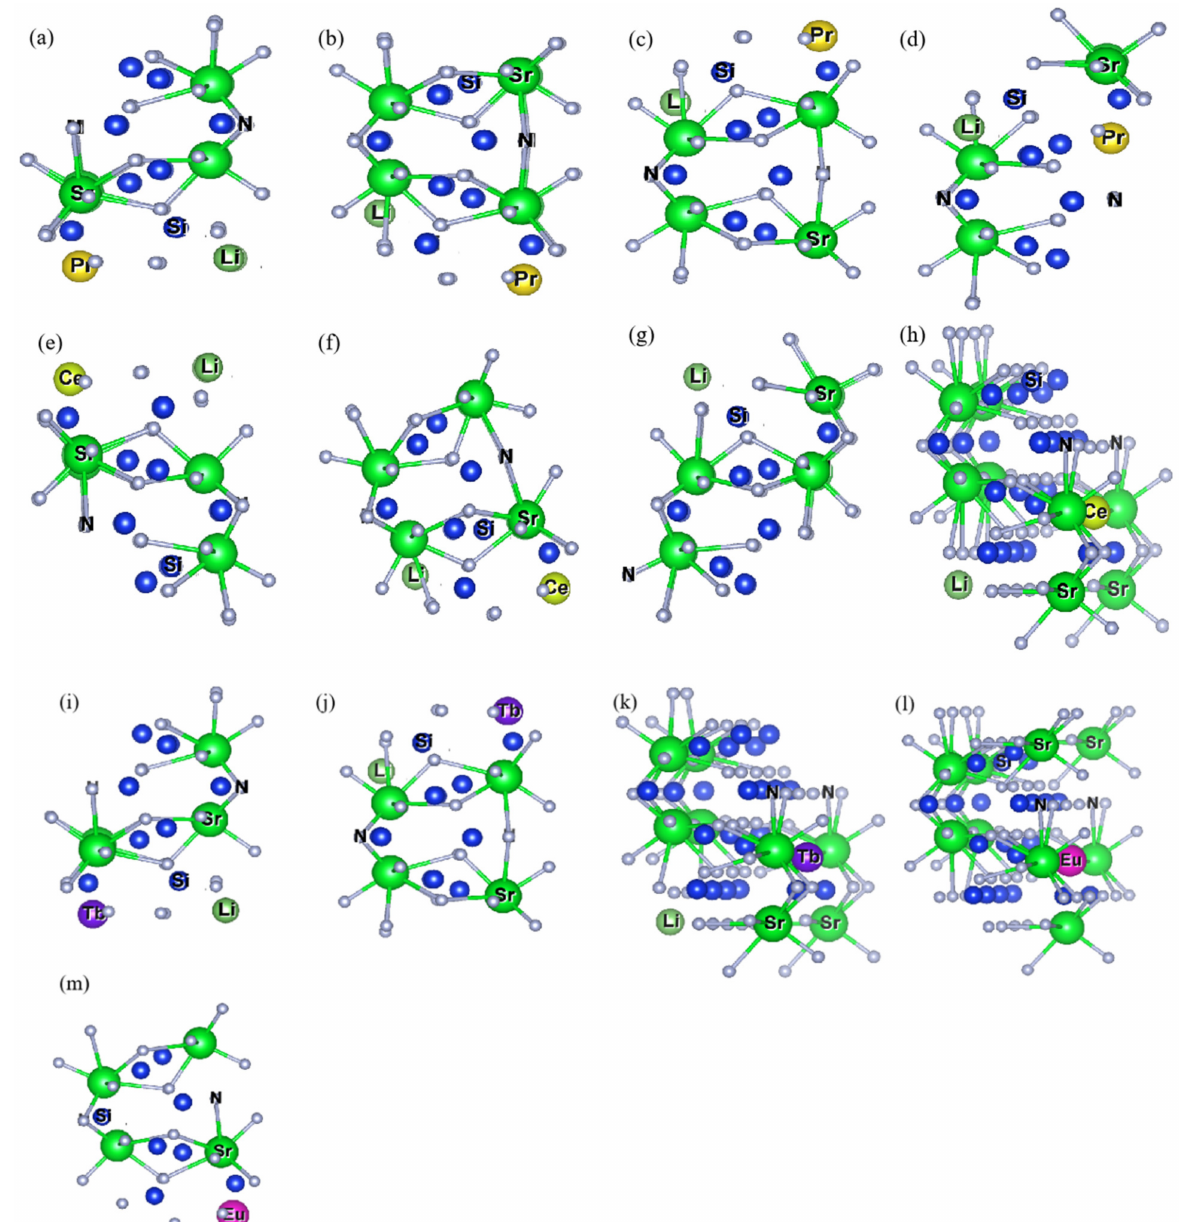
Figure 4. [SrN] coordination polyhedron diagram after substitution of Ln 3+ /Li + for Sr 1 and Sr 2 sites in Sr 2 Si 5 N 8 ( a – m ) Pr Sr1 Li Sr1 -Sr 2 Si 5 N 8 , Pr Sr1 Li Sr2 -Sr 2 Si 5 N 8 , Pr Sr2 Li Sr1 -Sr 2 Si 5 N 8 , Pr Sr2 Li Sr2 -Sr 2 Si 5 N 8 , Ce Sr1 Li Sr1 -Sr 2 Si 5 N 8 , Ce Sr1 Li Sr2 - Sr 2 Si 5 N 8 , Ce Sr2 Li Sr1 -Sr 2 Si 5 N 8 , Ce Sr2 Li Sr2 , Tb Sr1 Li Sr1 -Sr 2 Si 5 N 8 , Tb Sr1 Li Sr2 -Sr 2 Si 5 N 8 , Tb Sr2 Li Sr1 -Sr 2 Si 5 N 8 , Eu Sr1 -Sr 2 Si 5 N 8 , Eu Sr2 -Sr 2 Si 5 N 8